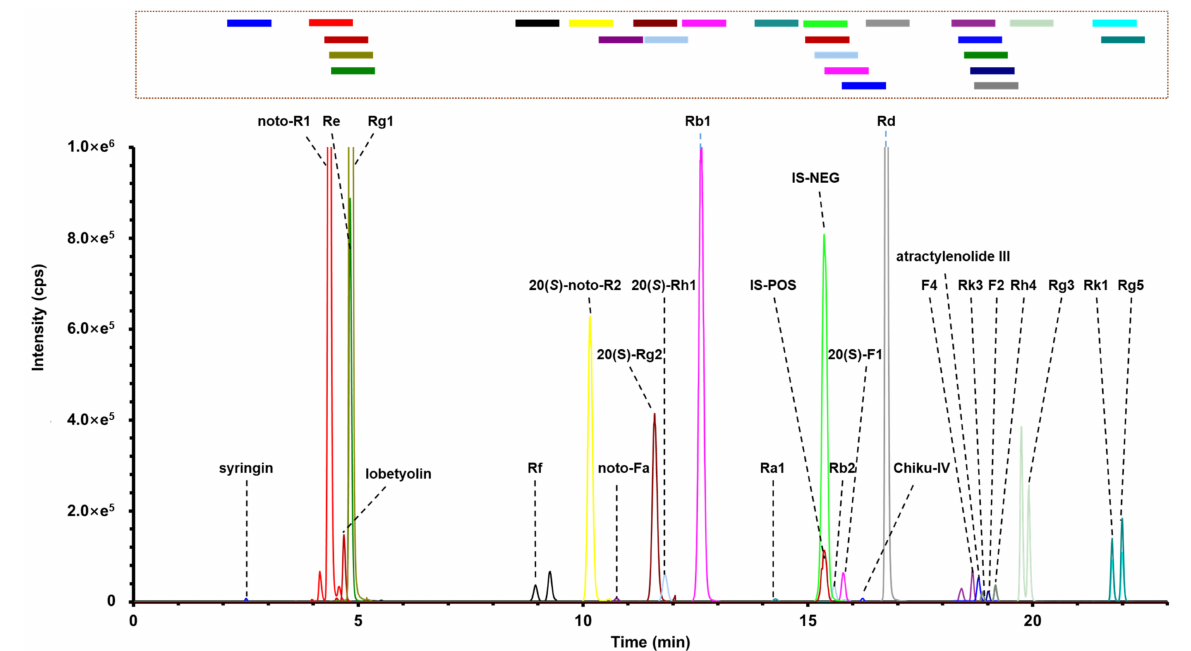
Figure 8. The sMRM chromatograms of 24 compounds obtained via the superposition of positive and negative ion